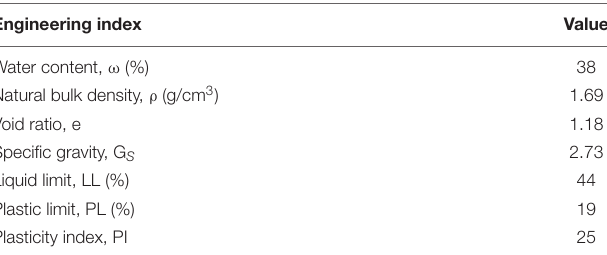
TABLE 1 | Soil index properties of tested